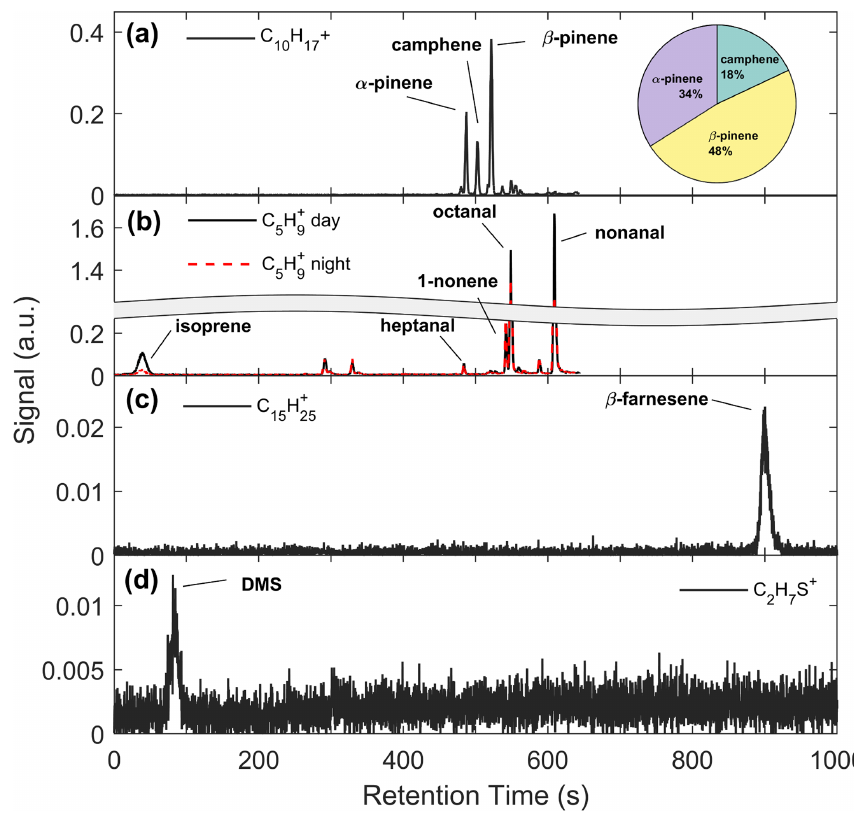
+ , (b) C 5 H + , (c) C 15 H + , and (d) C 2 H 7 S + with identified 17 9 25